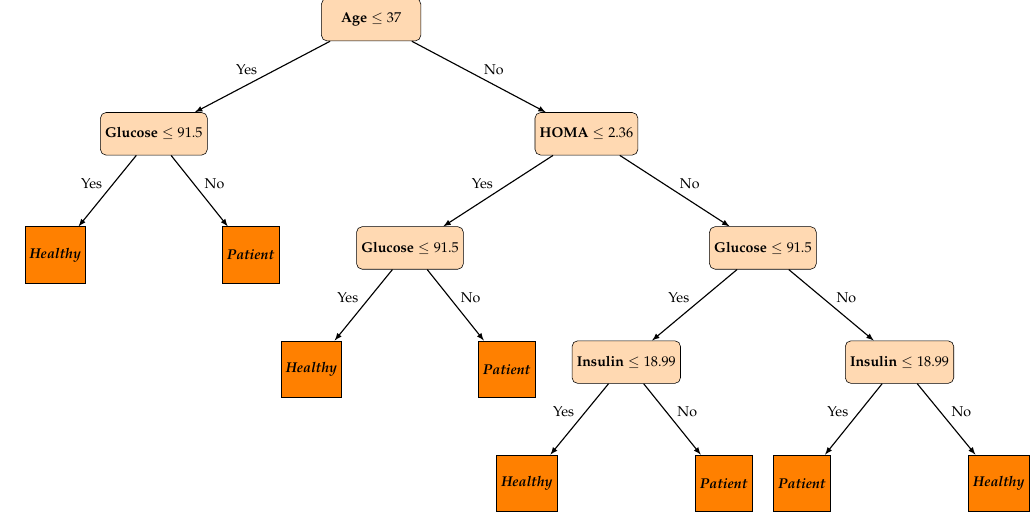
Figure 15. The interpretation of the learned inner model